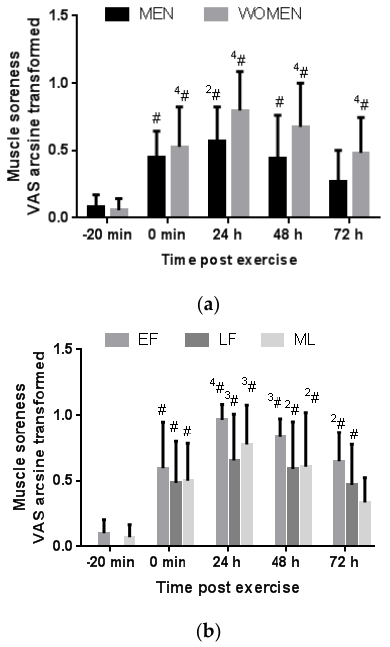
Figure 5. Comparison of visual analogue scale (VAS) rating of muscle soreness before and after downhill running between genders ( a ) and between menstrual phase groups ( b ). #, 2 #, 3 # and 4 # denotes a significant difference relative to pre-exercise (-20 min) within a group, p < 0.05, p < 0.01, p < 0.001 and p < 0.0001,